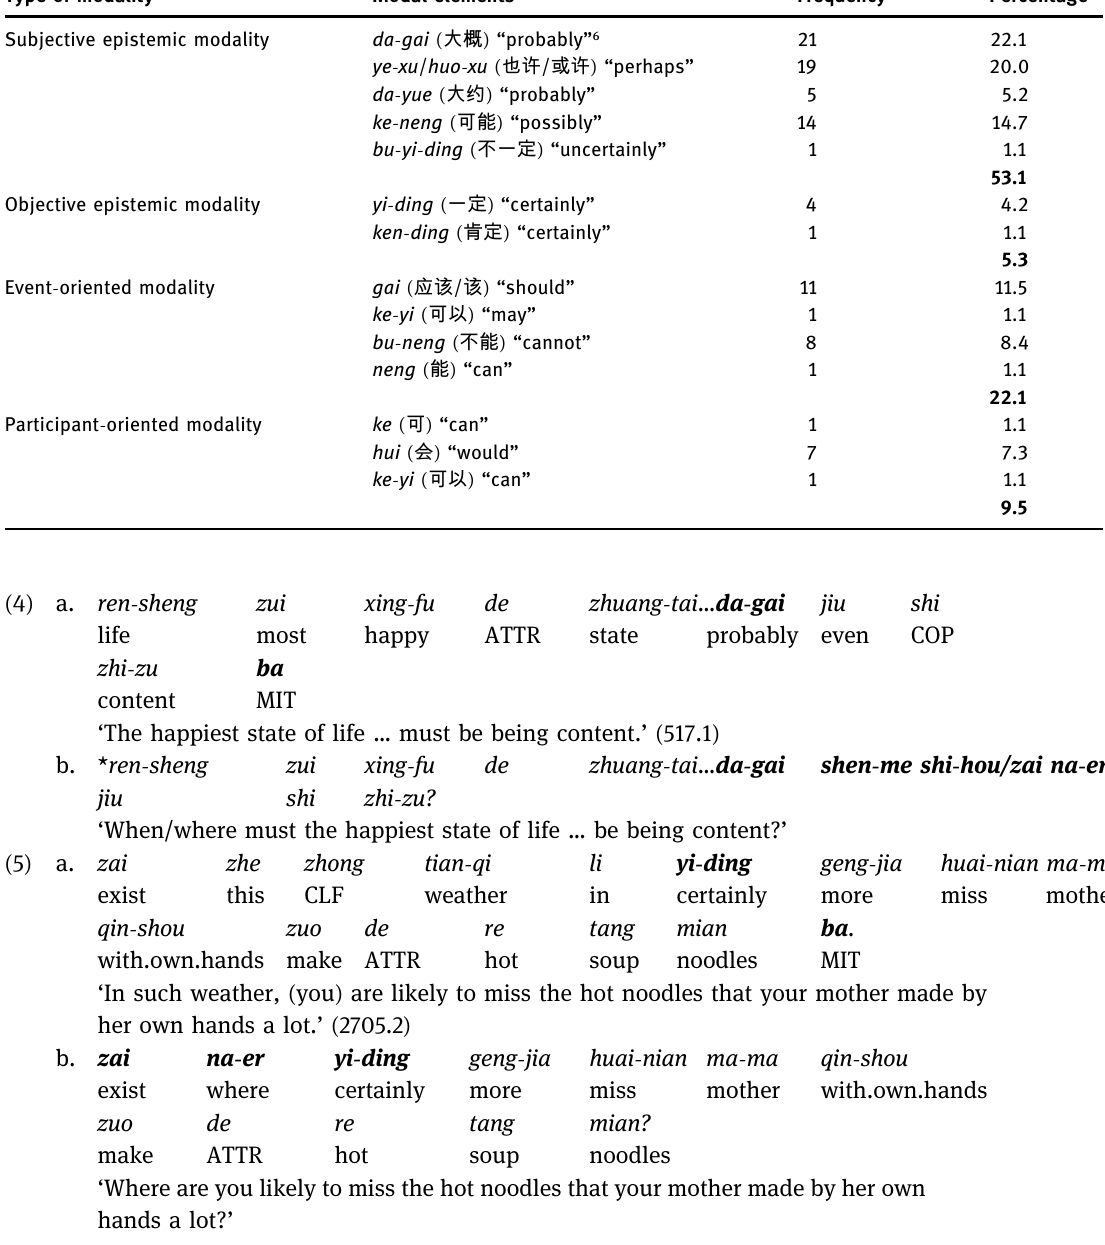
Table 3: Frequency of co - occurrence of ba with four types of modalities Type of